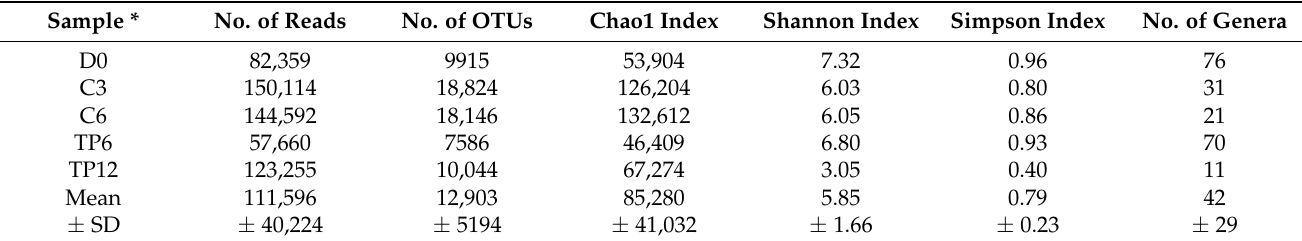
Table 1. Crisp grass carp sample information, microbial diversity, and sequence analysis.